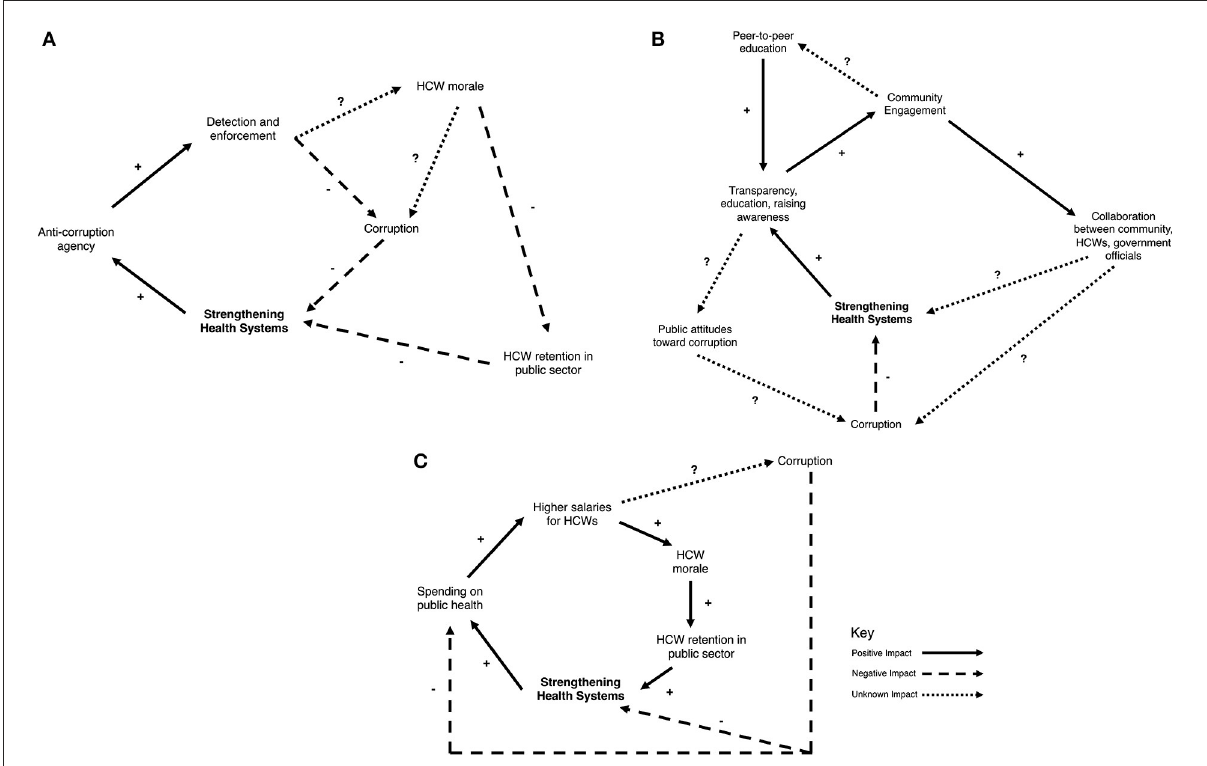
FIGURE3 Causal loop diagrams for the following anti-corruption strategies. (A) Anti-corruption agency, (B) community engagement, and (C) raising